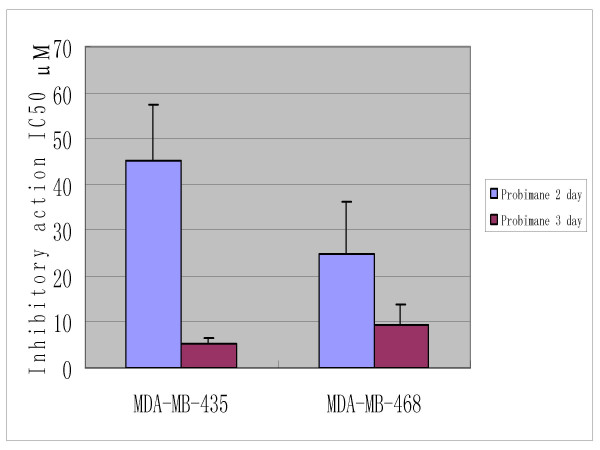
Differences of anticancer effects (IC50) of probimane for different exposure intervals by a MTT method, n = 3 for 2 independent tests.